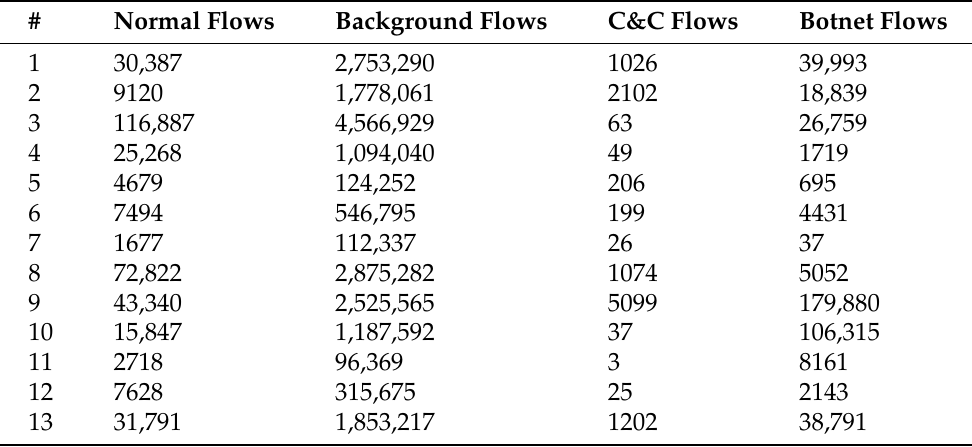
Table 1. Distribution of network traffic in the CTU-13 dataset for each scenario.